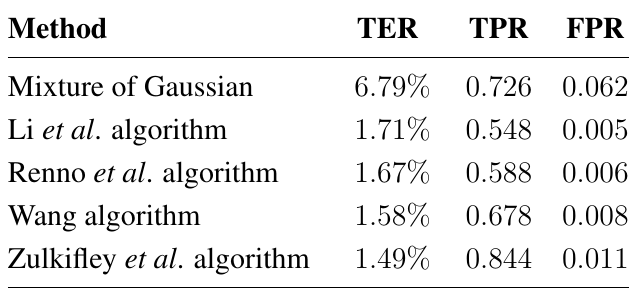
Table 4. Performance comparison between methods for the second video.